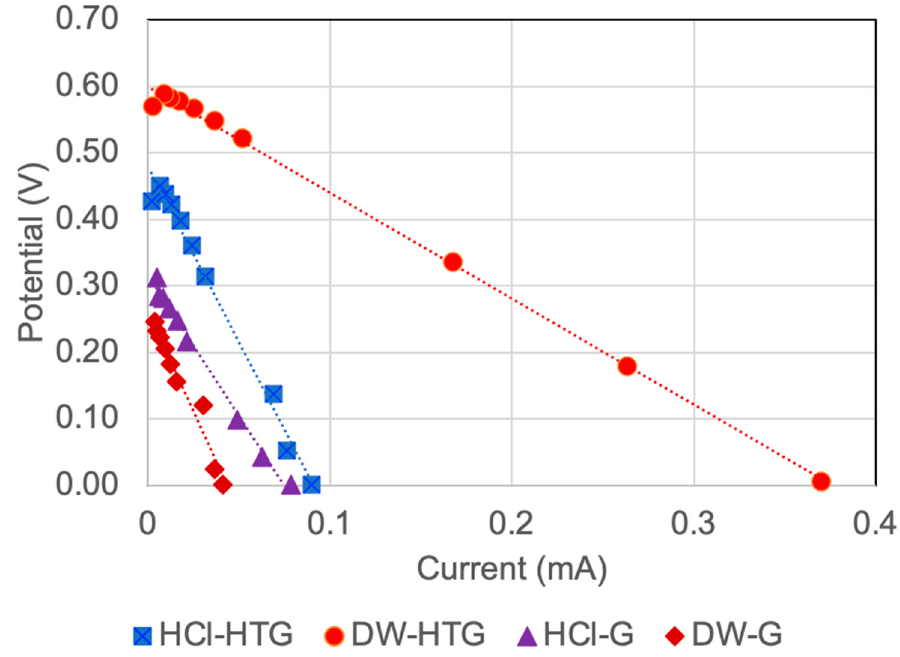
Figure 8. Polarization curves of the MFC system for ten different external resistances (15 Ω –220 k Ω ), two electrode materials, and HCl solution catholyte. HCl: HCl solution as a catholyte; HTG: hydrophilically-treated graphene; DW: distilled water; G: graphite.